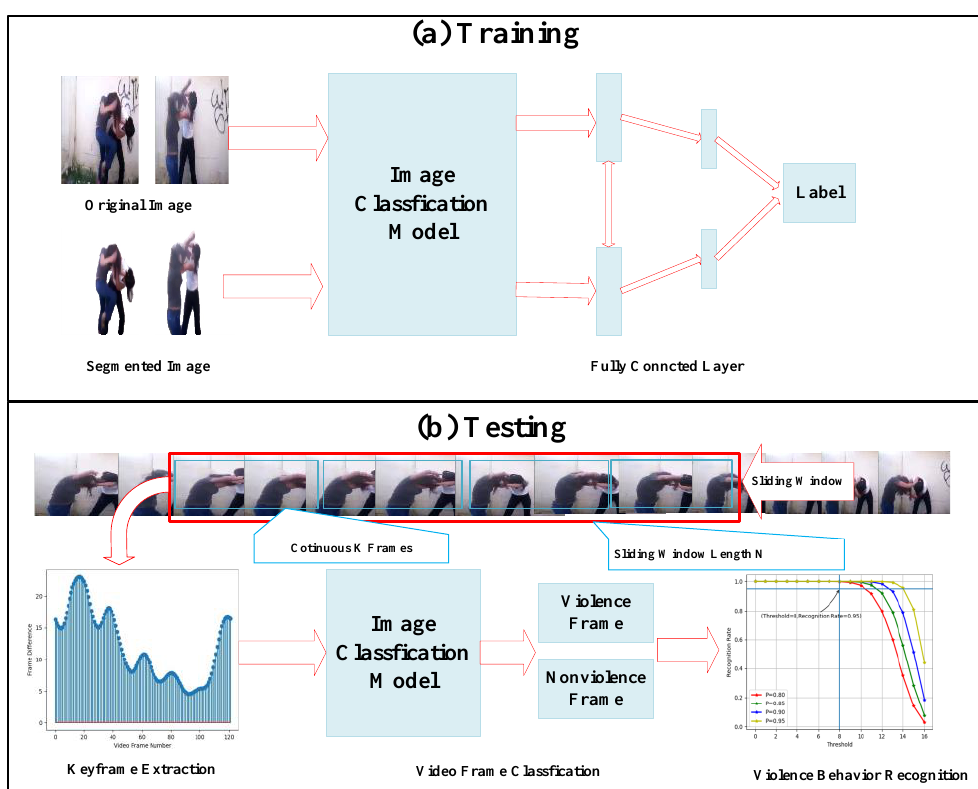
Figure 1. Our violent-behavior-recognition structure. ( a ) In training, the loss of segmented – original images and labels is reduced, which is equivalent to finding the minimum value of Formula (1). At the same time, the fully connected layer of the segmented – original image gradually approaches, which is equivalent to reducing the value of ∆𝑙 𝑖 in Formula (2). The segmented image and original image make the model pay more attention to the foreground information, thereby reducing the in- terference of background information. ( b ) The keyframe extraction algorithm uses the frame-differ- ence method to extract keyframes from the sliding window (continuous 𝑁 frames) and selects the local maximum frame as the keyframe in every continuous 𝐾 frame.